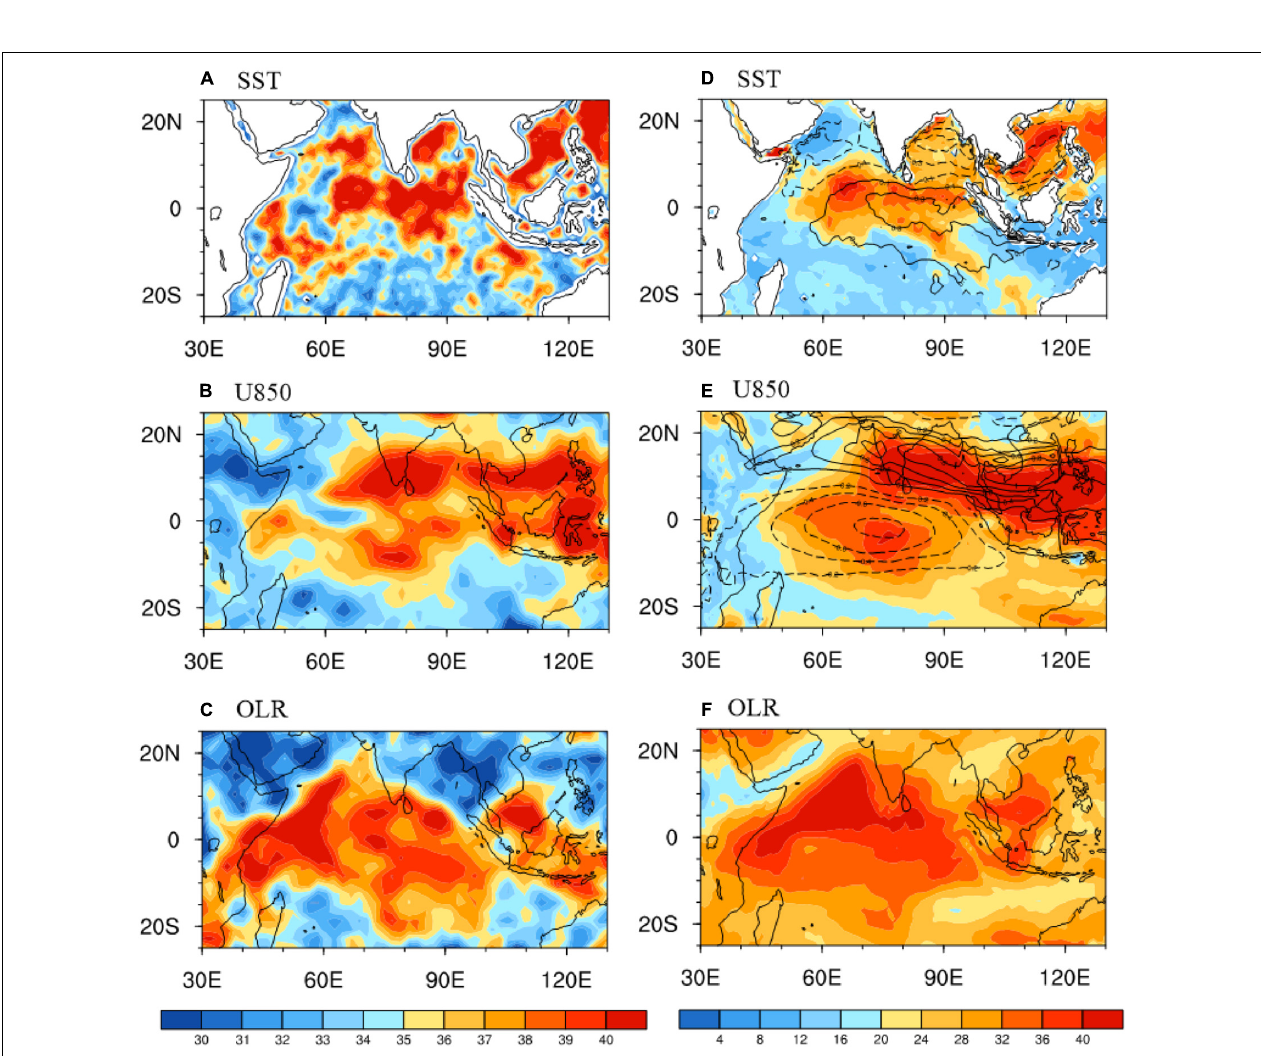
Frontiers in Marine Science |